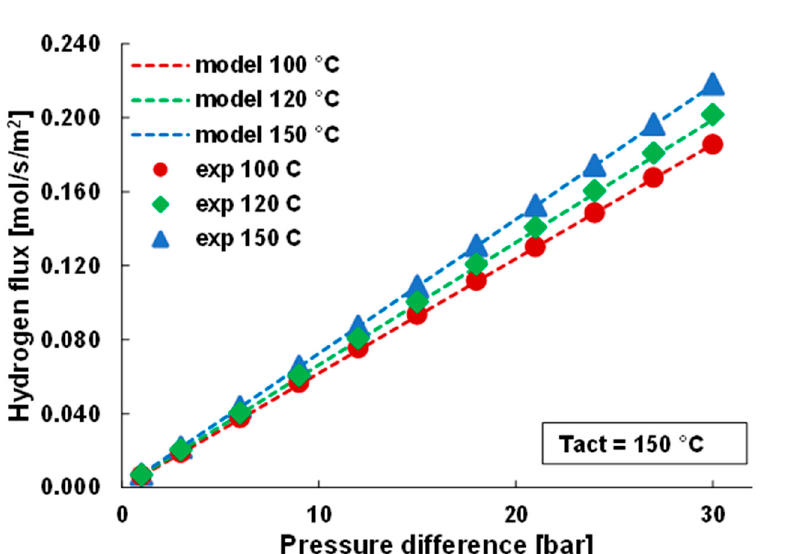
Figure A1. Comparison between ( a ) N 2 , ( b ) CH 4 and ( c ) H 2 flux at different temperatures between experimental and modelled description based on configuration diffusion equation CMSM-550.